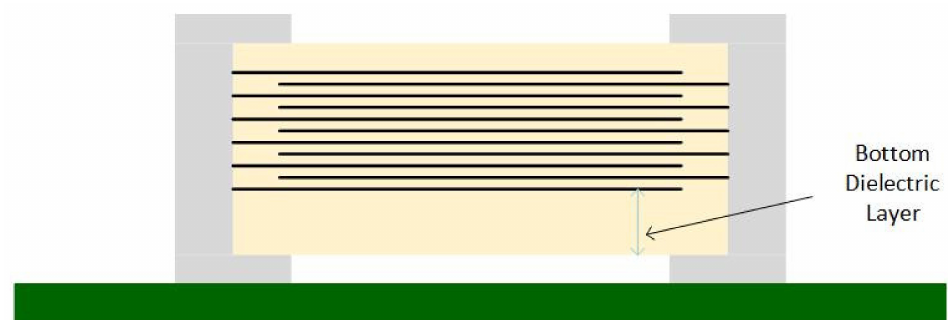
Figure 6. Thicker Bottom Dielectric Capacitor.